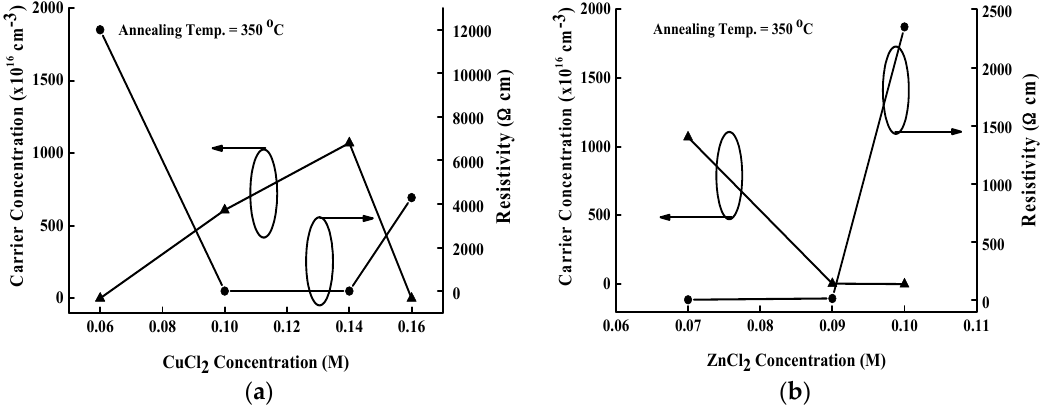
Figure 6. Carrier concentration and resistivity of the CZTS thin film as a function of the ( a ) CuCl 2 ; and ( b ) ZnCl 2 concentrations.